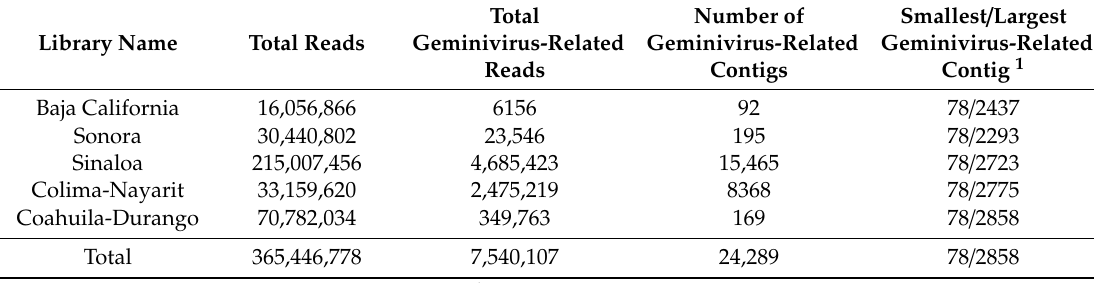
Table 2. Next generation sequence (NGS) data summary of reads and contigs mapping to Geminivirus